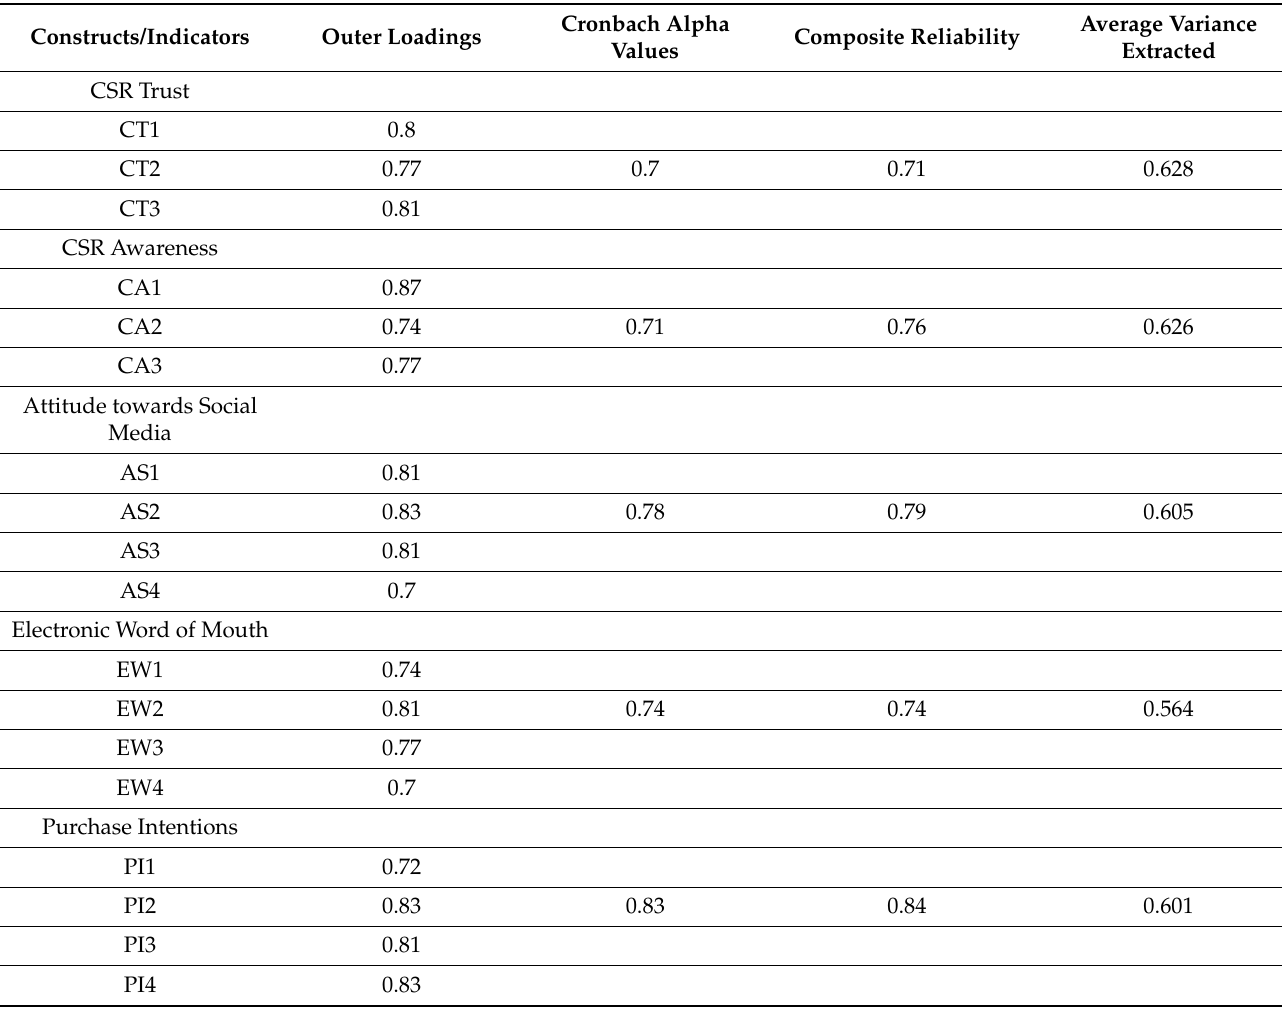
Table 6. Standardized loadings, validity, and reliability of the measurement model.